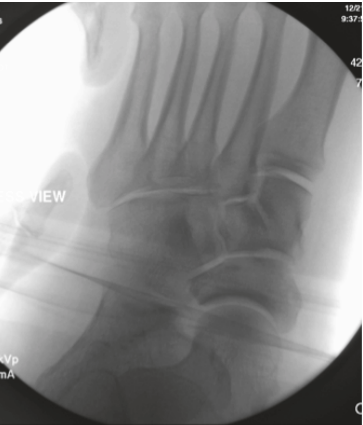
Figure 4: Intraoperative stress radiographs demonstrating intact first to third tarsometatarsal